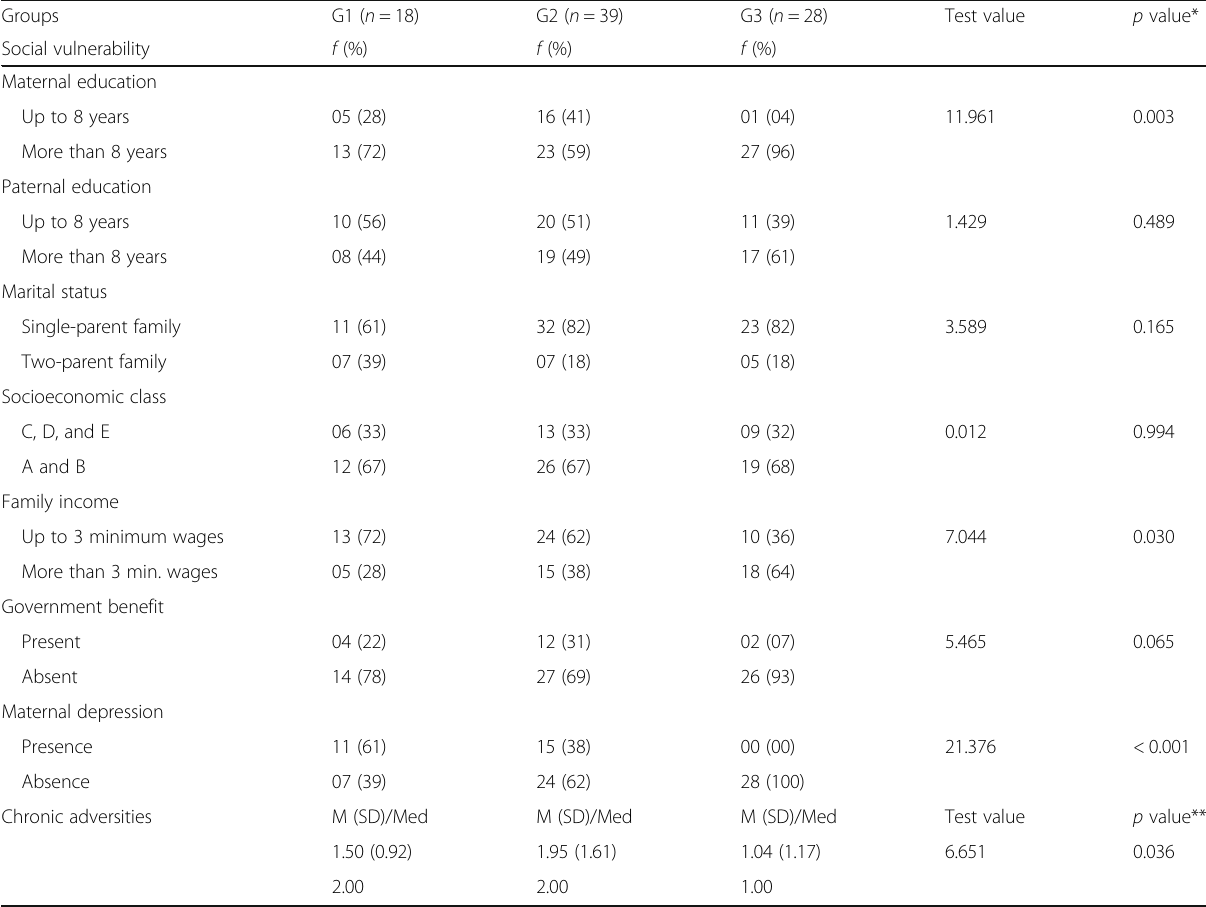
Table 2 Comparisons between the groups regarding social vulnerability, maternal depression, and chronic adversities ( n = 85)